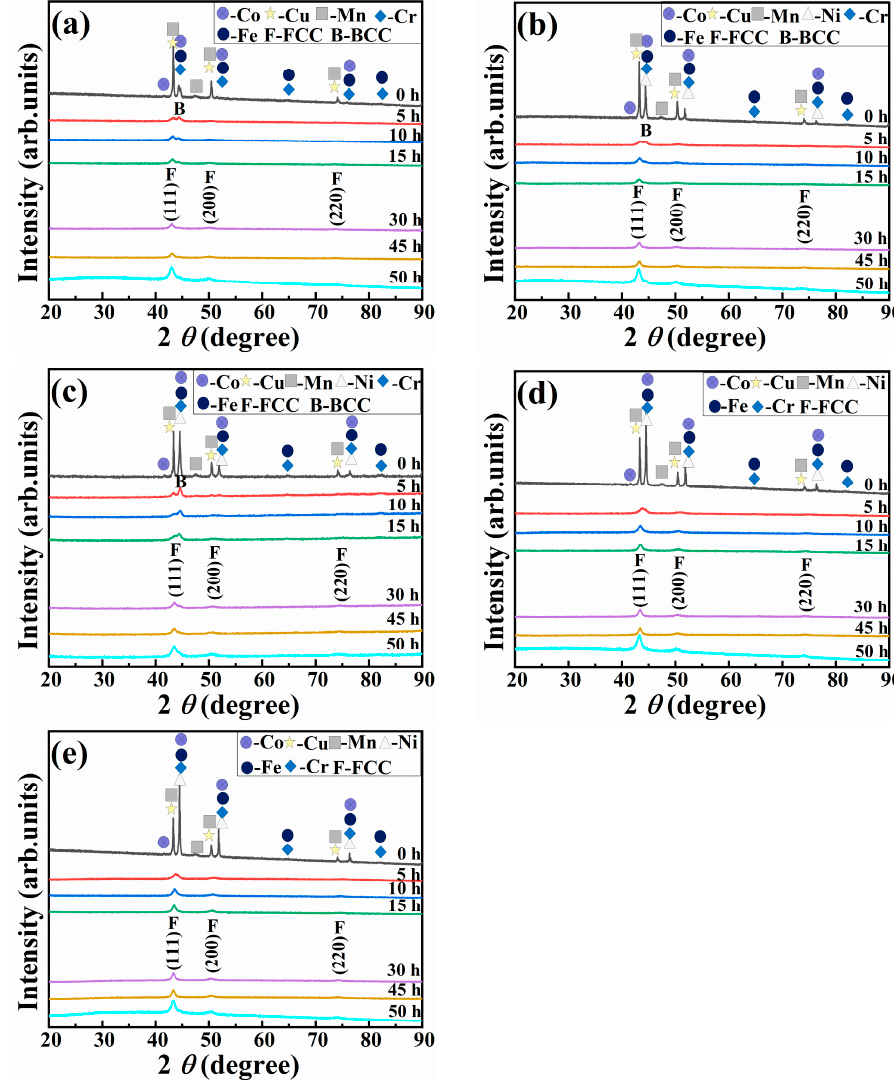
Figure 1. XRD patterns of CoCrCuFeMnNi x HEAPs after different ball milling time: ( a ) Ni 0 , ( b ) Ni 0.5 , ( c ) Ni 1.0 , ( d ) Ni 1.5 , ( e ) Ni 2.0